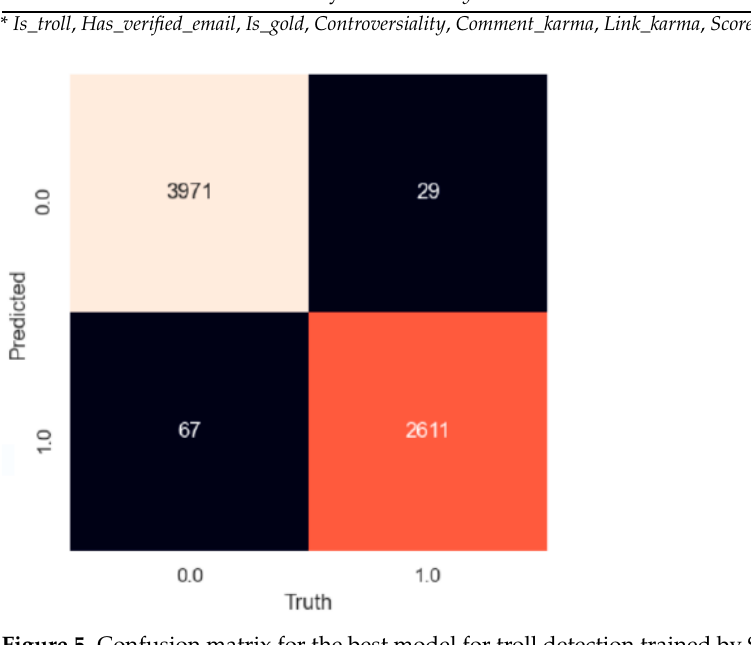
Figure 5. Confusion matrix for the best model for troll detection trained by SVM + GKRBF.